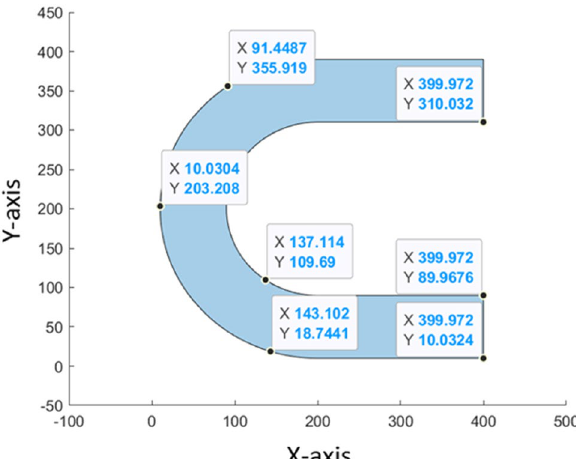
Figure 5. Sample of layer with some of it’s 2-D